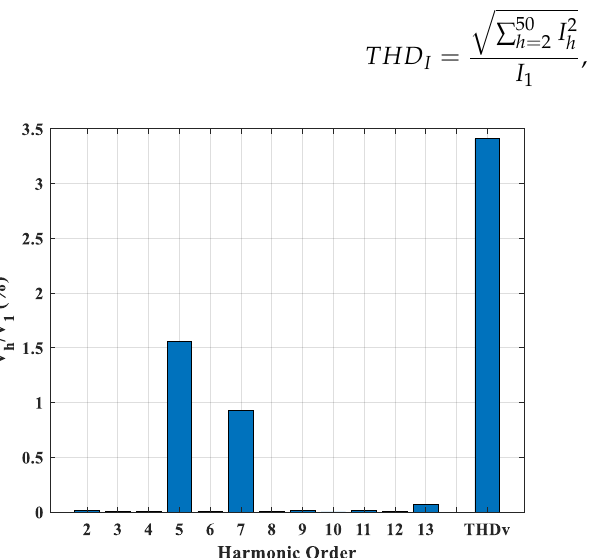
Figure 2. ( a ) Two-dimensional FE model of synchronous generator. ( b ) Coupling SG and load mod- els within Maxwell Circuit Editor.